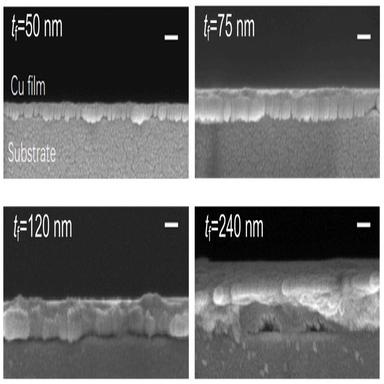
SEM images showing the cross section of the Cu-film/PEN assembly for tf=50 nm, 75 nm, 120 nm, and 240 nm, respectively (tf denotes the film thickness). The scale bars are 100 nm.